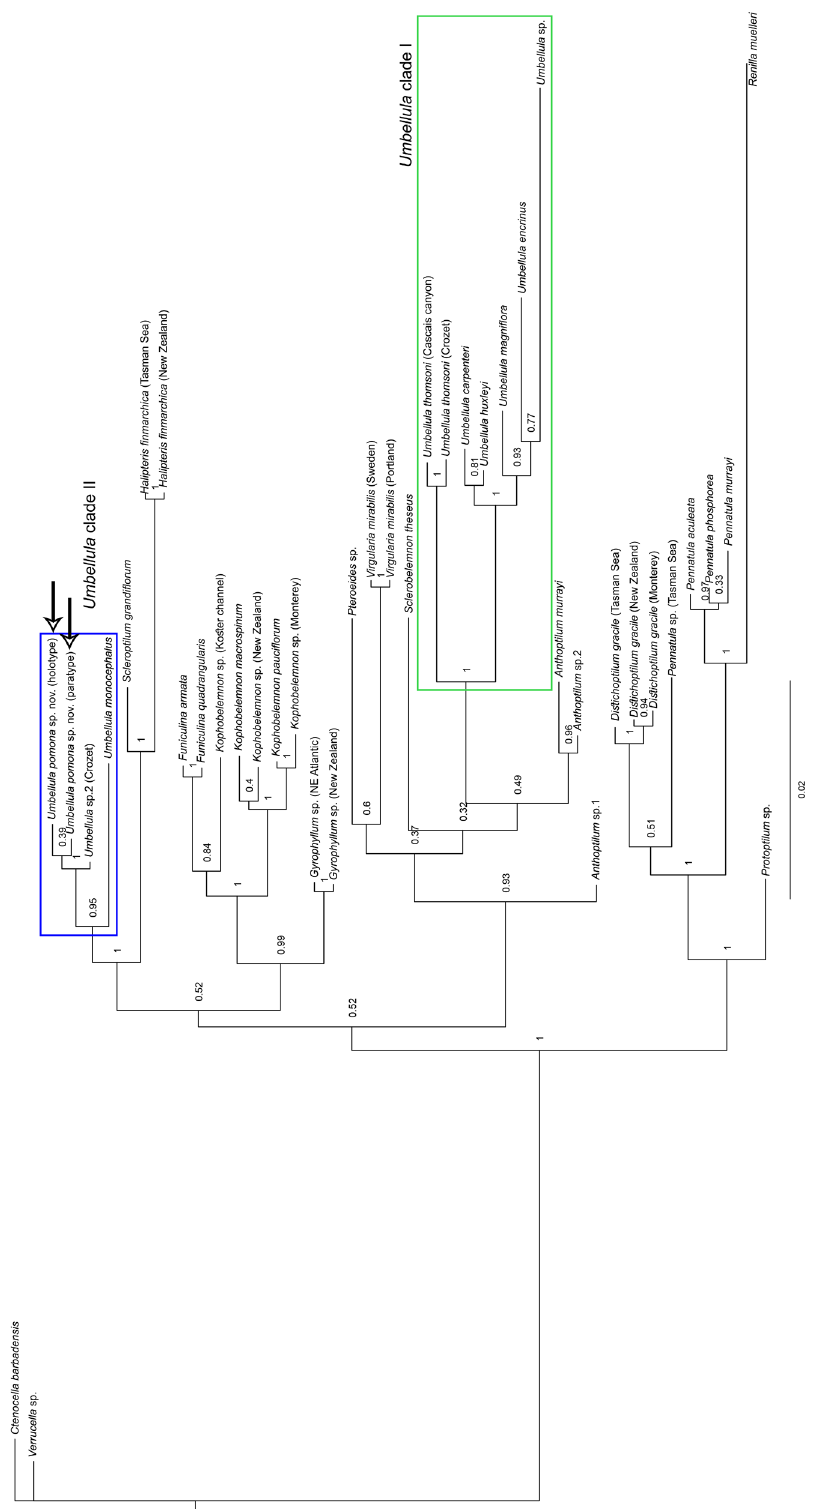
Fig. 9. Phylogenetic reconstruction of the concatenated set of the two mitochondrial genes (mtMutS and ND2) based on the Bayesian analysis. Nodes include the Bayesian posterior probabilities. Arrows